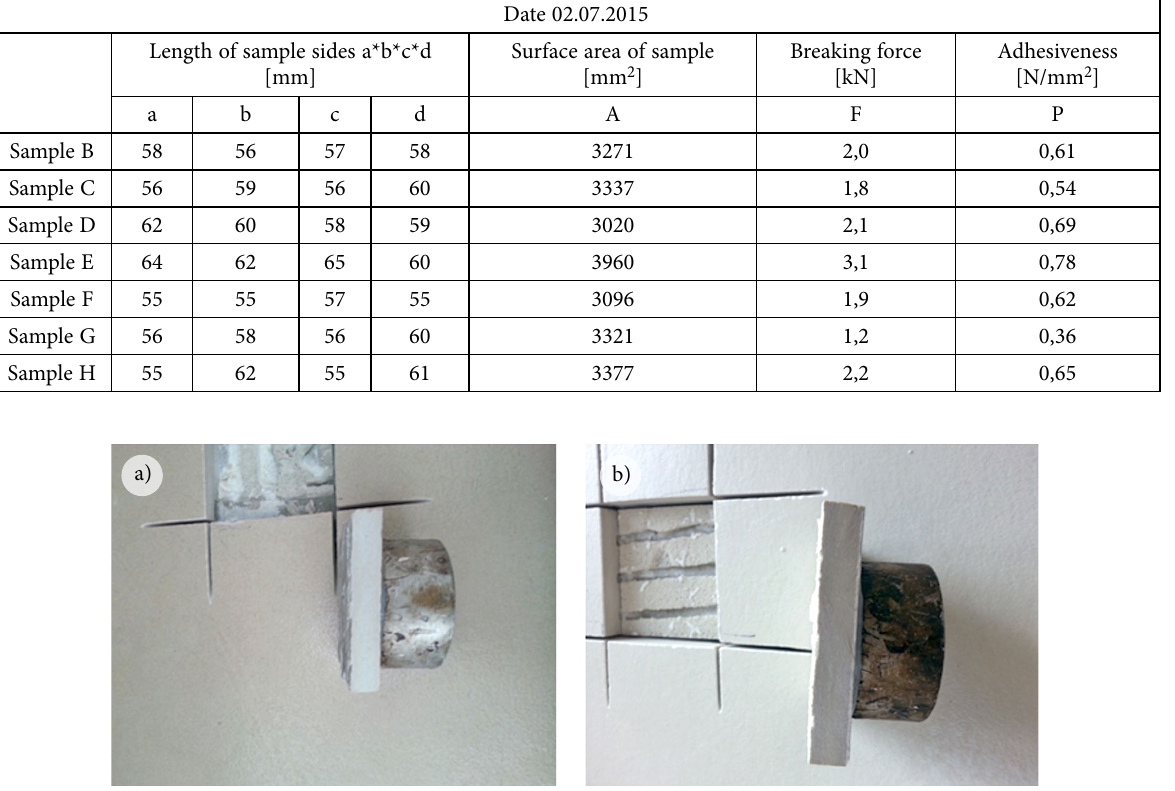
Fig. 5. The idea of the functioning of the advisory system for repairing industrial floors (own study) plicant (served this function artificial neural networks associated with fuzzy knowledge base used for learn- ing network) output vector is generated, under which proposals were coded by system regarding the possi- bility repair the damage. Later the specific solutions for the material was generated by algorithm of repair and additional – costs, the needed for specific regimes. Table 2. The results of the adhesion of ceramic tiles to the surface in a three-layer system using the pull-off apparatus (own